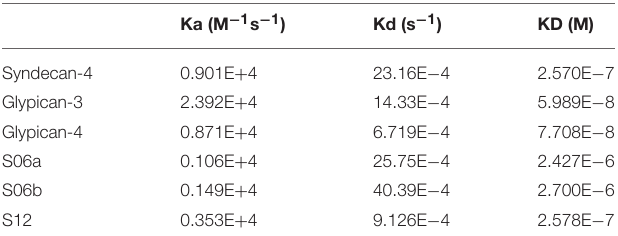
TABLE 1 | Kon, koff, and KD of recombinant glypicans and syndecans and oligosaccharides.